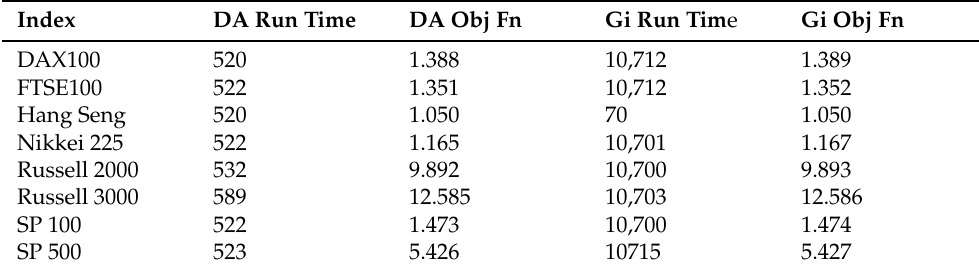
Table 5. Run Times and Objective Function.